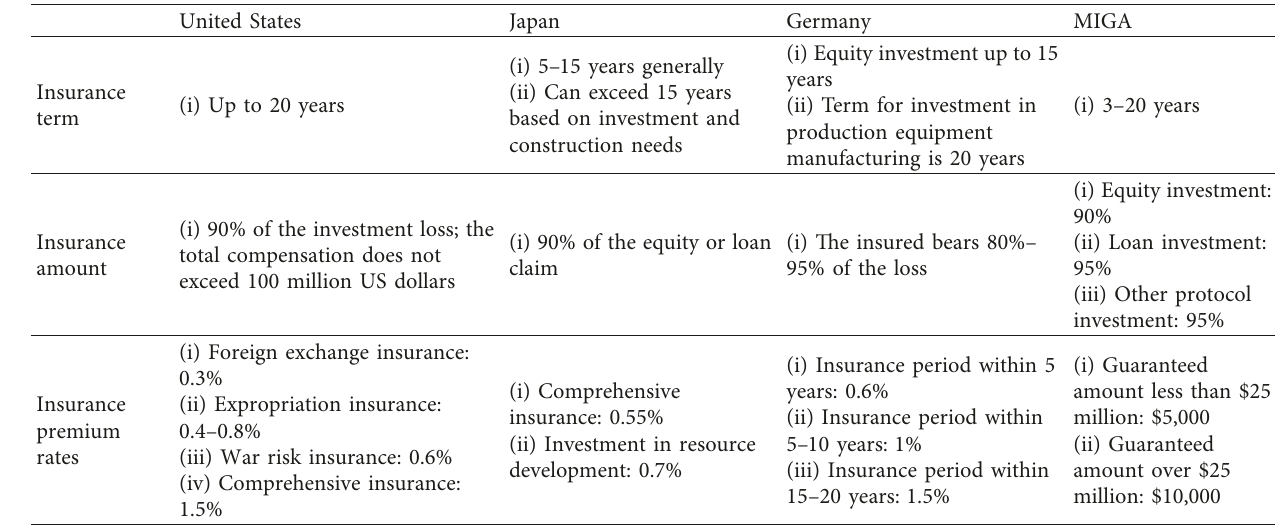
Table 3: Comparison of overseas investment insurance term, insurance amount, and insurance premium rates of various